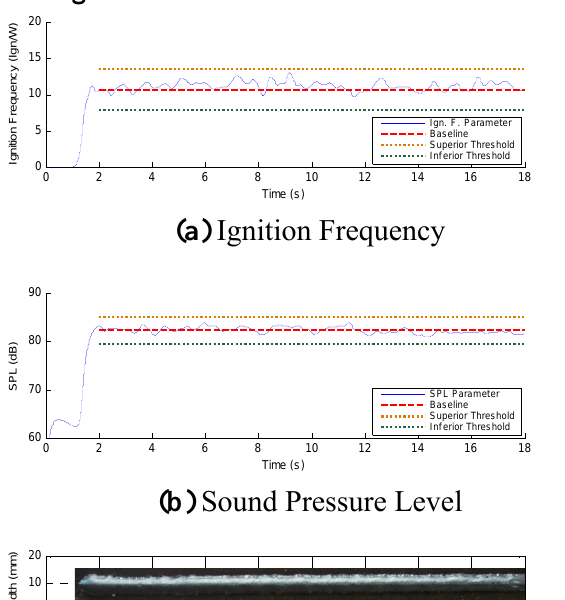
Figure 12. Parameters without Disturbance. Figure 13. Parameters with Disturbance